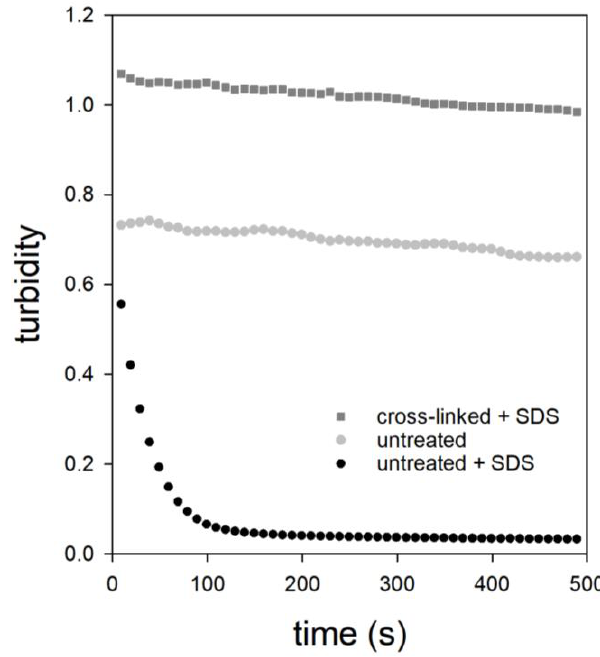
Figure 2. Turbidity as a function of time of CMPs with (dark gray) and without TGase treatment (black) after the addition of SDS. The measured data of a CMPs sample without TGase treatment and SDS addition is also shown (light gray).